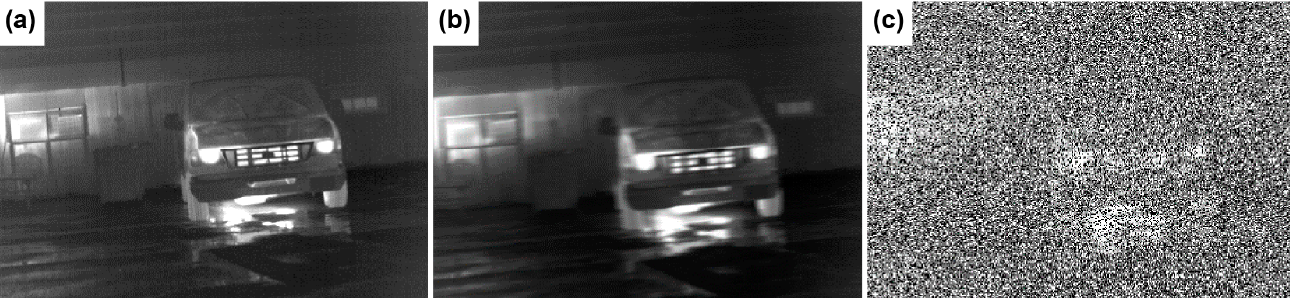
Figure 7. A comparison of deblurring effects of the two models on a truck image. ( a ) The original truck image, ( b ) the image deblurred using Lp_LOGS, and ( c ) the image deblurred using Lp_HOGS. ( d – f ) The local enlarged images of the red boxes from ( a – c ), respectively. A comparison of Figure 6a,c with Figure 7b,c revealed that Lp_LOGS and Lp_HOGS achieved satisfactory deblurring effects in terms of motion blur. Furthermore, the perfor- mance edge of the proposed model was similar to that under the Gaussian and the box blurs. The deblurring effects are depicted in Figure 7b,c,e,f. 3.2. The Comparison with Other Methods This section compares the proposed model with existing models, including ATV [4], ITV [5], L0TVPADMM [9], and HNHOTV-OGS [10]. Nine distinct IR images were selected as test images. The truck, the buildings, the car, and the figure images were 384 × 288 pixels, and the garden, the stairs, the corridor, the road, and the zebra crossing images were 506 × 408 pixels. The experimental results are listed in Table 4 and the unit of PSNR as dB.